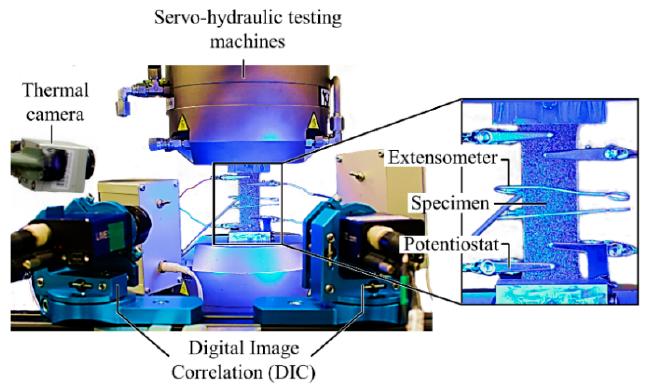
Figure 5. Experimental setup for fatigue tests.